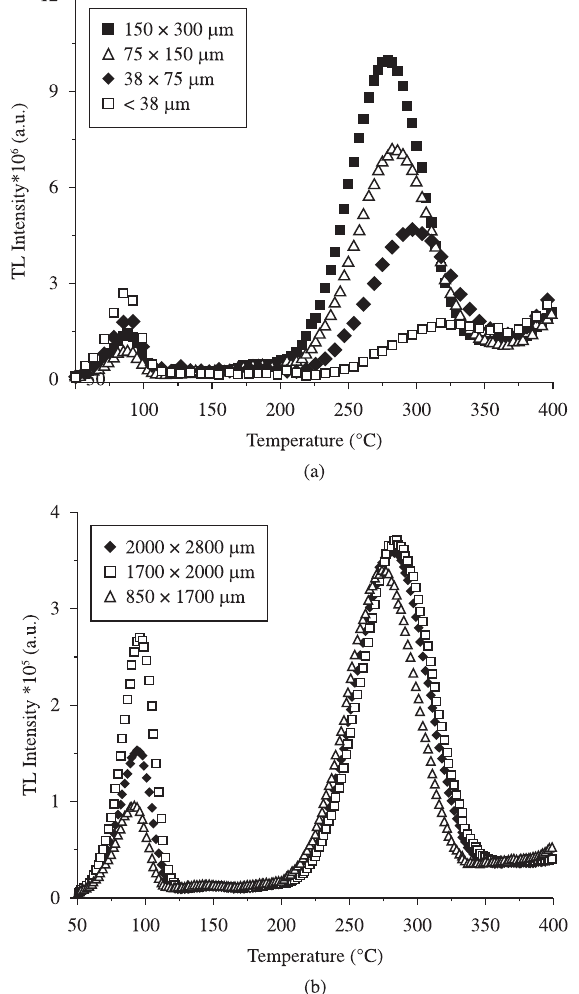
Figure 3. TL glow curve of quartz particles sensitized with 25 kGy of γ radiation and heat-treatments at 400 °C (test dose: 50